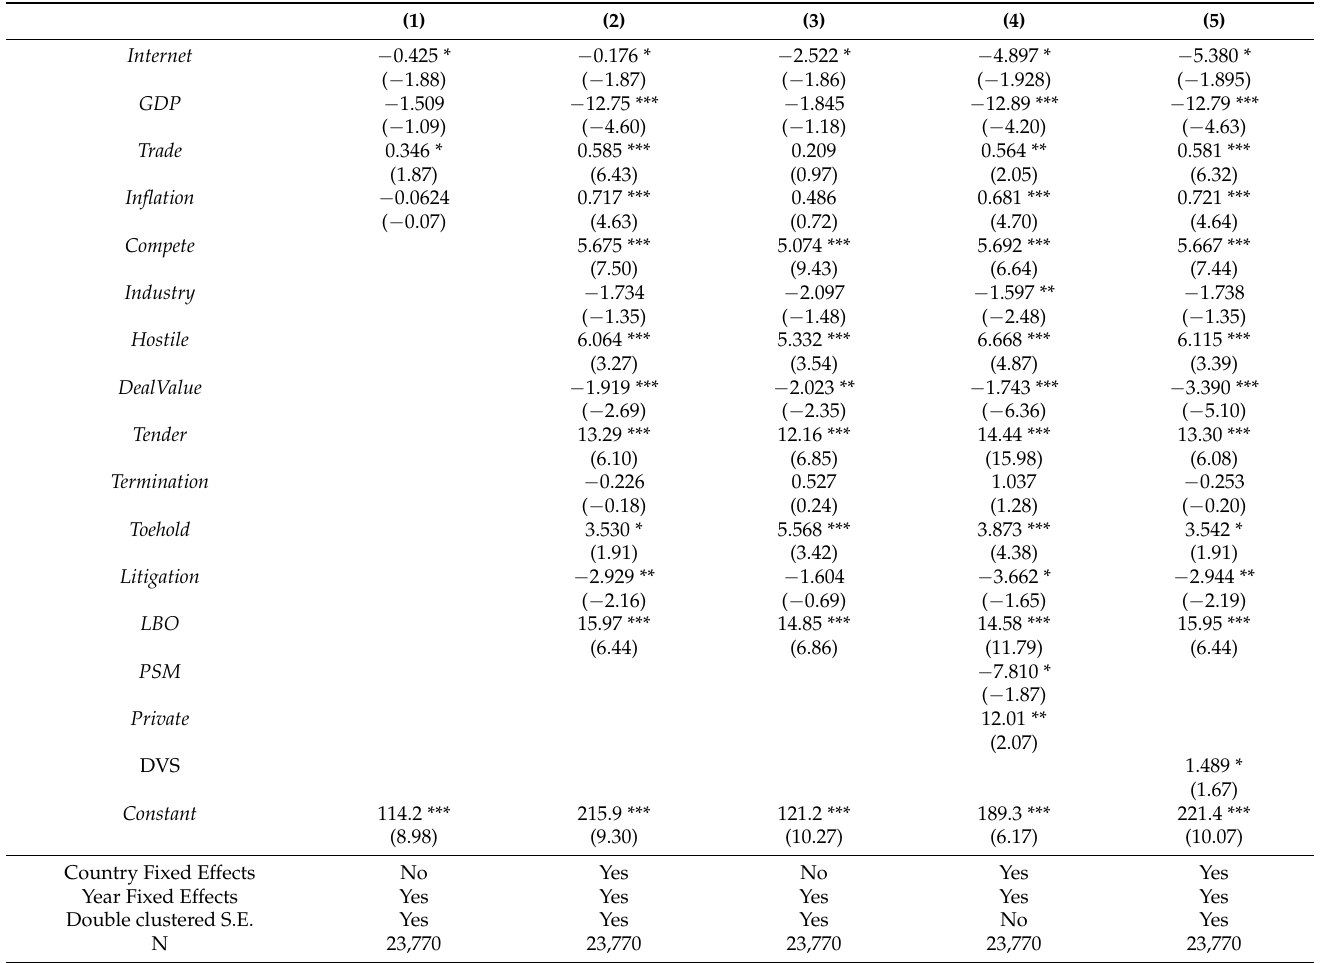
Table A9. This table presents the results of five panel fixed effects regressions for the full sample of global M&A deals. The dependent variable is CashPaid , the percentage of cash included in the payment for the M&A transaction. The main independent variable is Internet , an indicator variable that equals 1 if the Internet has been introduced in the target country at the time the deal is announced. In addition to the control variables described previously, macro-economic variables for the acquiring country are included. Standard errors are double-clustered by year and